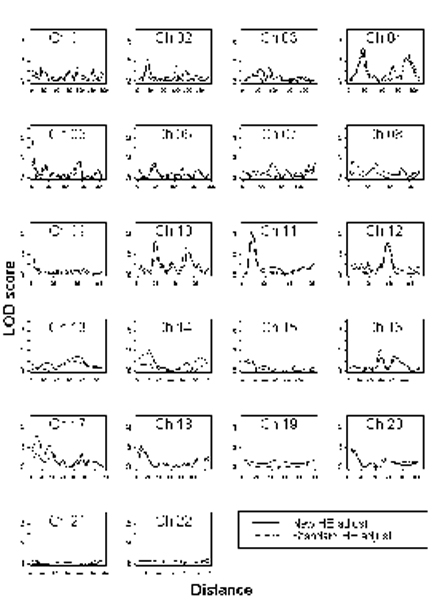
LOD scores based on data from visit 1 The solid curves represent the multipoint LOD scores obtained after adjusting for gender, age, and drinking level using the adjusted HE method. The dashed curves represent the multipoint LOD scores obtained after adjusting for gender, age, and drinking level using the standard HE method in S.A.G.E.